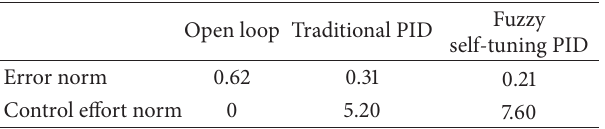
Figure 4: The midpoint responses of the beam using the original system model and reduced-order model. axis at a speed of Ω = 150 rad/s. All simulations are Table 4: Comparison of control effect of traditional PID and fuzzy self-tuning PID implemented using MATLAB 2012a programming language.